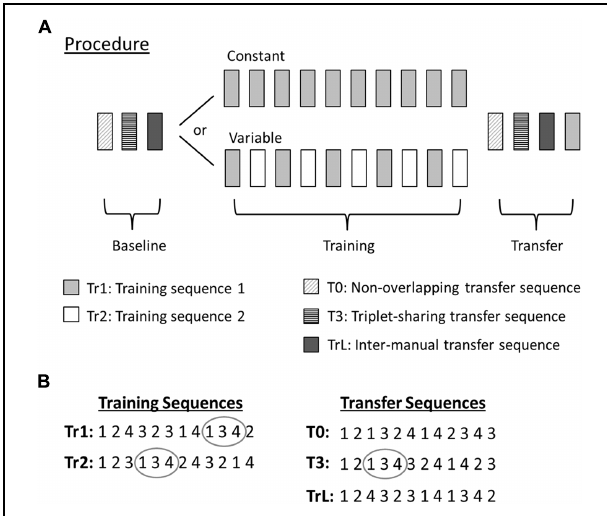
FIGURE 1 | Experimental procedure and sequential stimuli. (A) The experimental procedure consisted of three sessions: Baseline, Training, and Transfer. The Baseline session consisted of one block of each of the three transfer sequences (T0, T3, TrL) and the Transfer session consisted of the same three sequences (presented in the same order as during Baseline) plus one additional block of Tr1 at the end of the session. Block order during Baseline was randomized across participants and counterbalanced between groups. In the Training session the Constant group performed 10 blocks of the Tr1 sequence and the Variable group alternated between Tr1 and Tr2 blocks. All blocks were separated by 20 s of rest, both within and between sessions. Each block contained 10 uninterrupted sequence repetitions, thus requiring a total of 120 responses (12 sequence elements × 10 repetitions) per block. (B) Sequence structure of the training (left) and transfer (right) sequences. The training sequences (Tr1 and Tr2) shared six triplets with each other, three of which were also shared with sequence T3 (one example of a shared triplet encircled). None of the training sequences shared any triplets with sequence